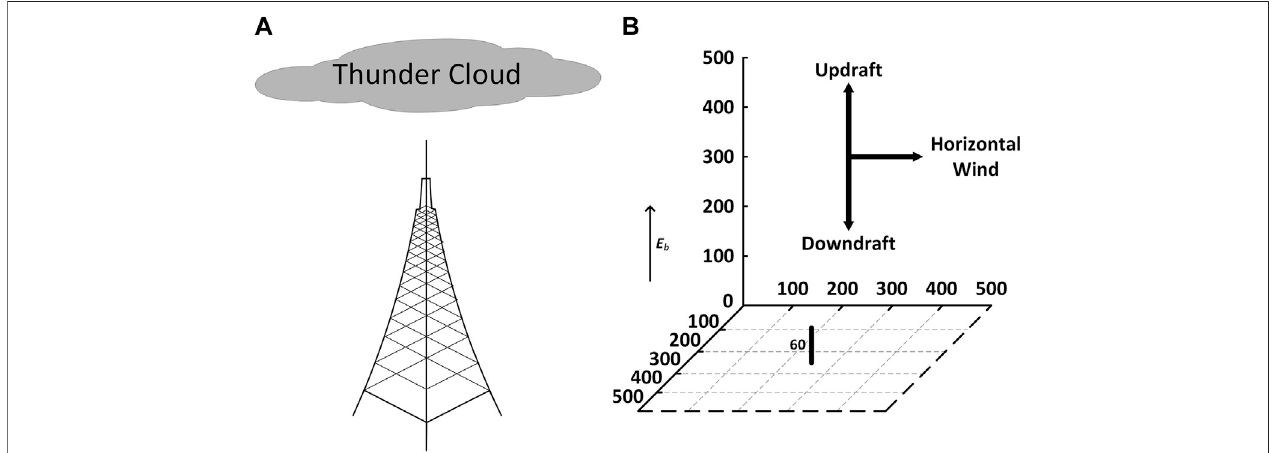
FIGURE 1 | Signal tower (A) and model settings (B) . All units of distance in (B) are